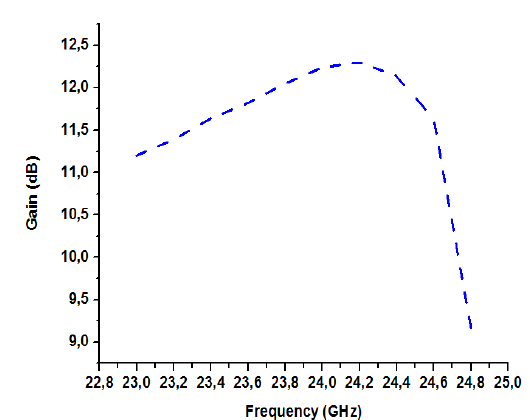
Figure 5: CST simulated g ain versus the frequency of the proposed single